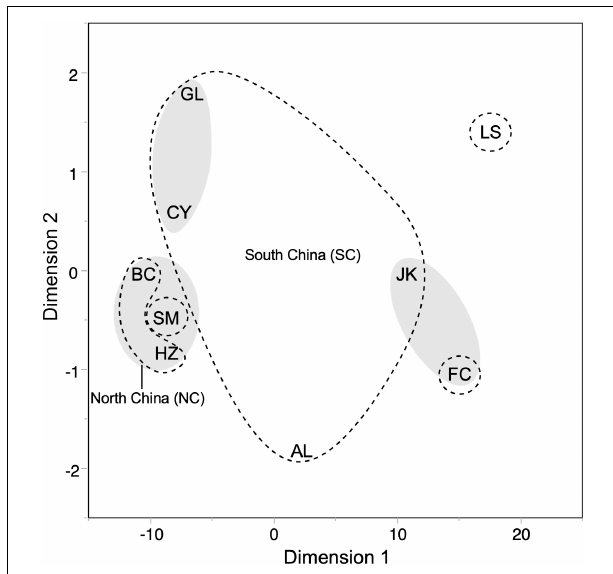
FIGURE 6 | A MDS plot showing acoustic proximity of all nine geographic populations in two-dimensional space organized according to acoustic distance between syllable types estimated from all measured parameters. Boundaries indicated by dashed lines enclose the five geographic regions tested for independence (significant differences between means of multiple parameters). Gray ellipses indicate relatively close proximity visualized in two dimensions based on the correlations between the means of the seven continuous parameters representing each syllable